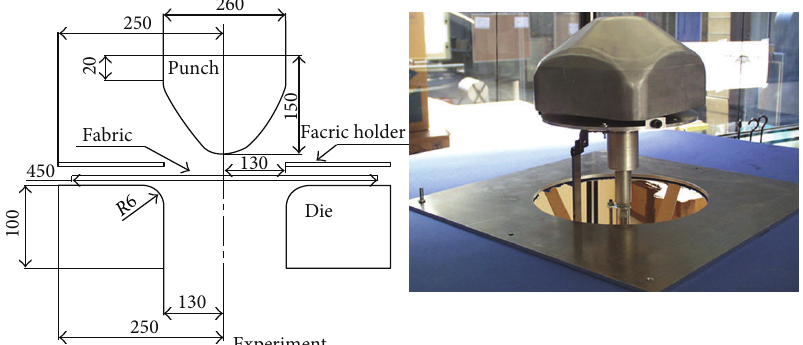
F 16: Geometry of deep drawing